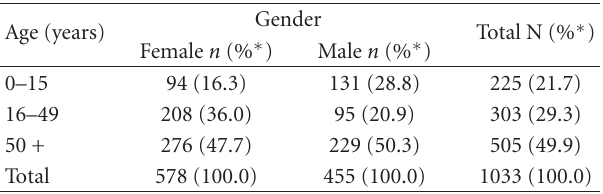
Table 1: ITP patients by age and gender.